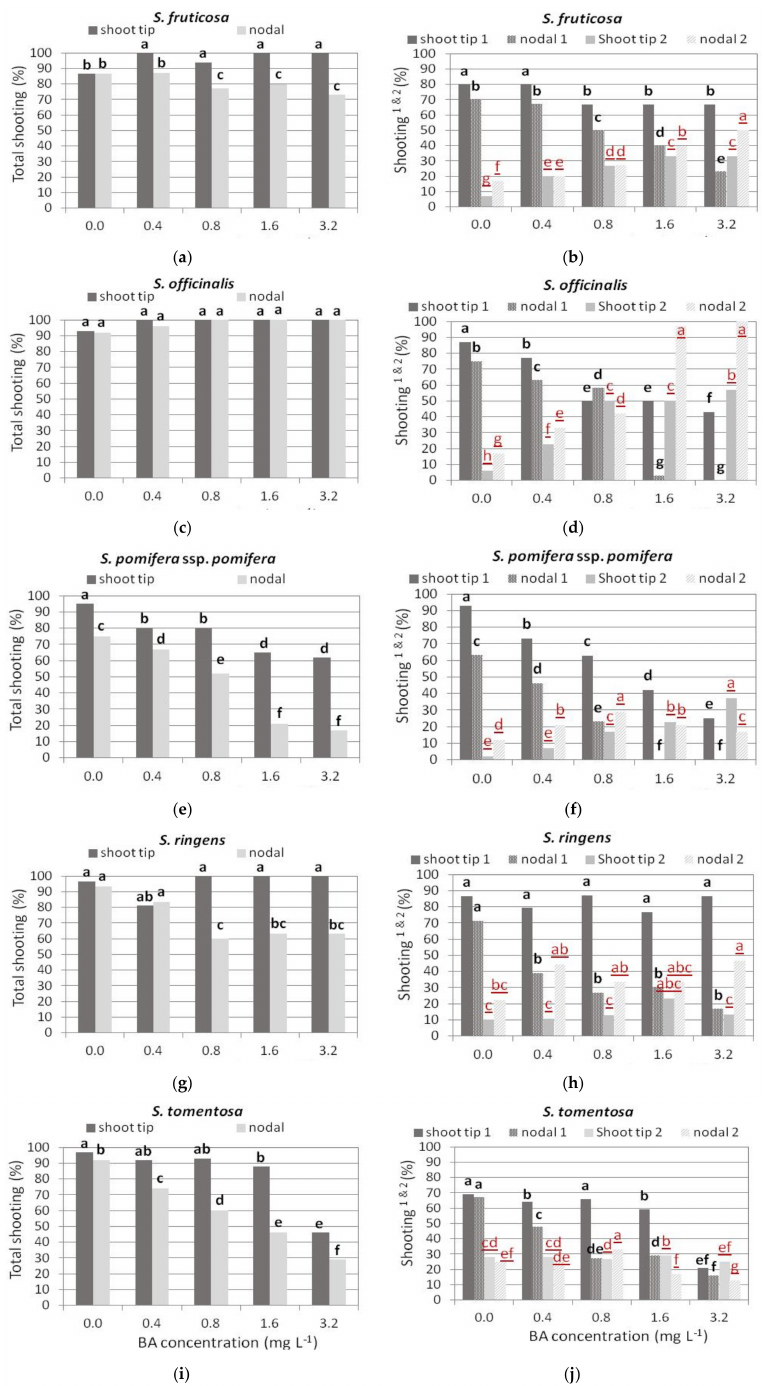
Figure 4. Effect of 6-benzyladenine (BA) concentration on explant response percentage for shoot production when shoot tip or single node (nodal) explants of each Salvia species shown were cultured on MS medium, either hormone free or supplemented with 0.01 mg L − 1 1-naphthaleneacetic acid (NAA) and BA concentration marked. Total shooting (%): percentage of explants that responded for shoot production. Explants formed both normal and hyperhydrated shoots. Explants formed only hyperhydrated shoots. Response of explants (black bold letters) was statistically analyzed separately from the respective explants (red underlined letters). Mean separation using Student’s t , p ≤ 0.05; means followed by the same letter are not significantly different at p ≤ 0.05, n =